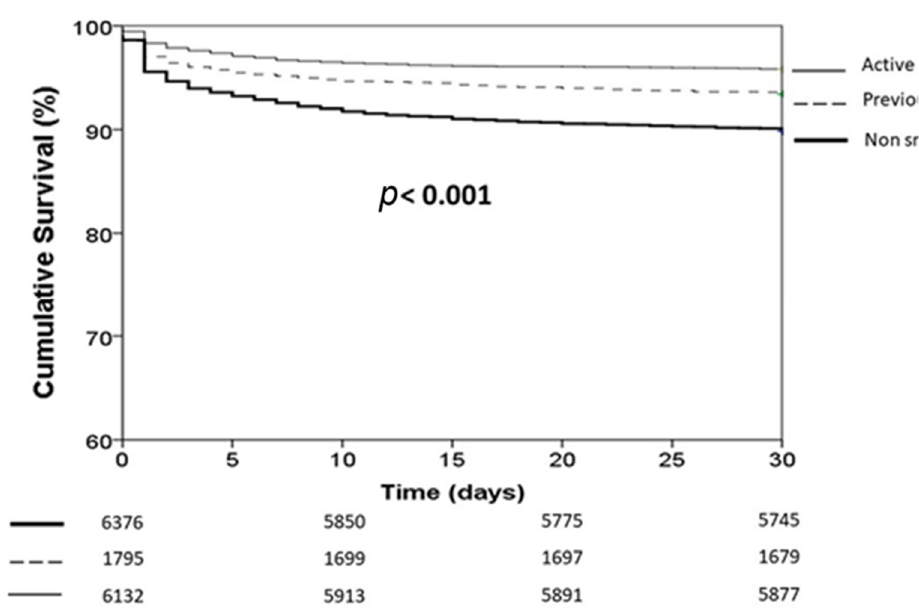
Figure 3. Kaplan–Meier survival curves of STEMI patients according to smoking status.